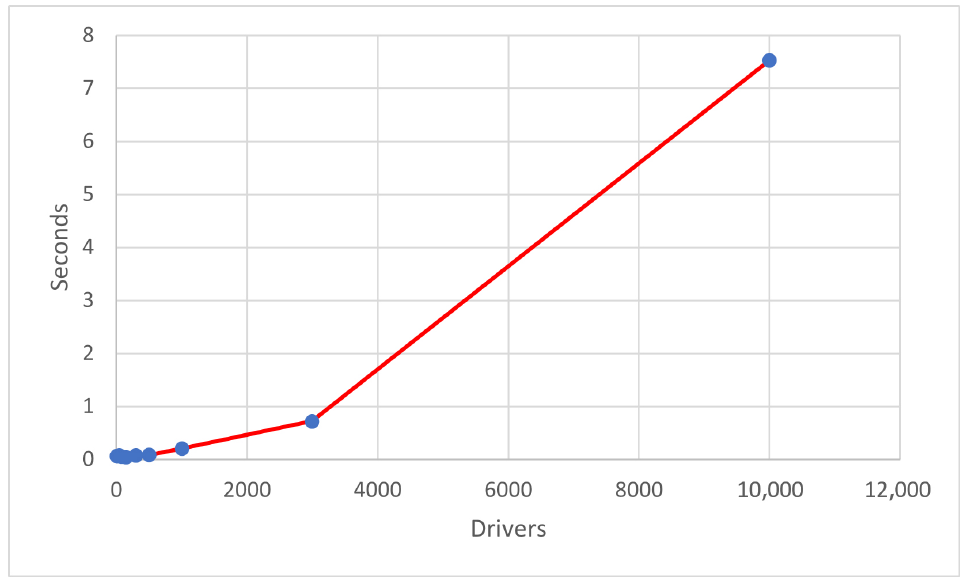
Figure 3. Time variation over the number of drivers.